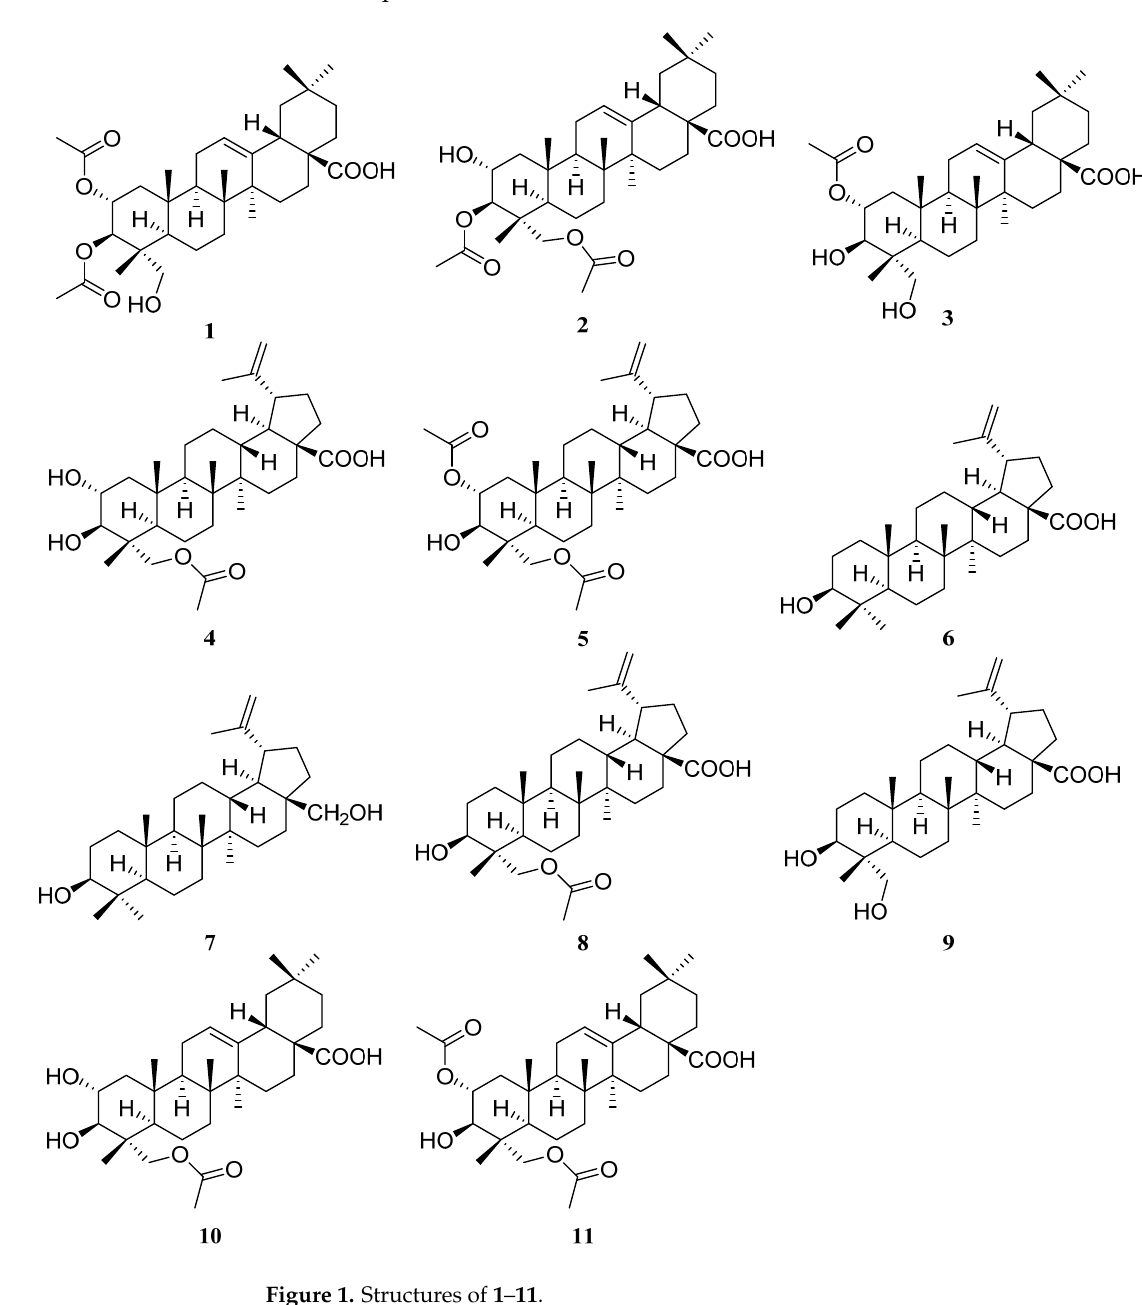
Figure 1. Structures of 1 – 11 .